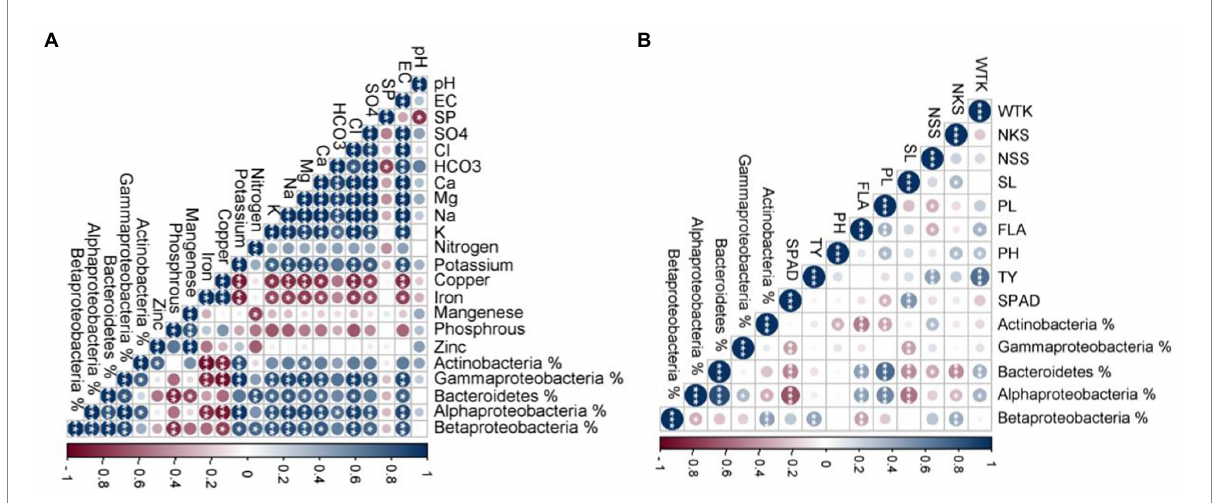
FIGURE 8 (A) Pearson’s correlation matrix between the percentage of the target taxa (obtained by 16S rRNA next-generation sequencing) and soil physicochemical properties. (B) Pearson’s correlation matrix between the percentage of the target taxa (obtained by qPCR) and the wheat growth parameters. The color and size variation of circles in the figure are proportional level and direction (positive or negative) of the correlation between traits where, EC; Electrical Conductivity, SP; Saturation Percentage, WTK; the weight of thousand kernels, NKS; the number of kernels/spike, NSS; the number of spikelets/spike, SL; spike length, PL; peduncle length, FLA; flag leaf area, PH; plant height, TY; total yield/plant, and SPAD; chlorophyll content